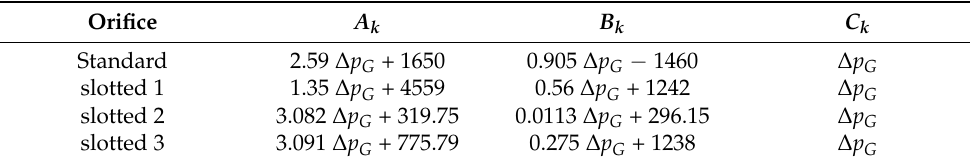
Figure 8. Relation between A, B and C factors and pressure for dry air. Table 4. Values of correction factors for investigated